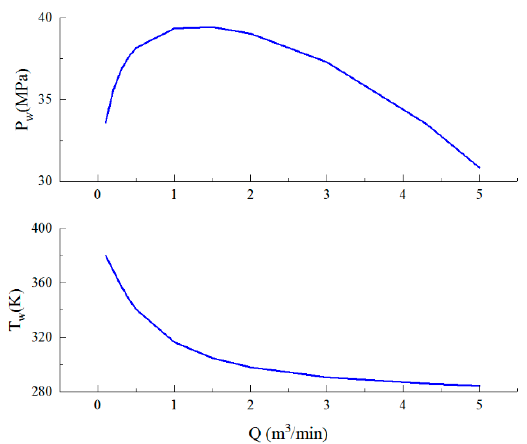
Figure 7. Bottom hole pressure and temperature under different displacement.